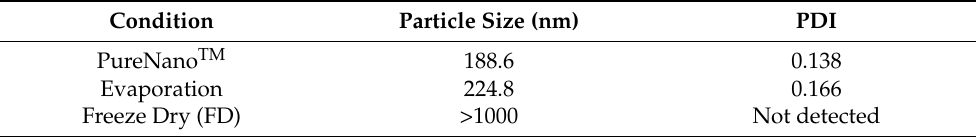
Table 1. Particle sizes of silymarin (SLM) suspensions and freeze-dried (FD) powder of